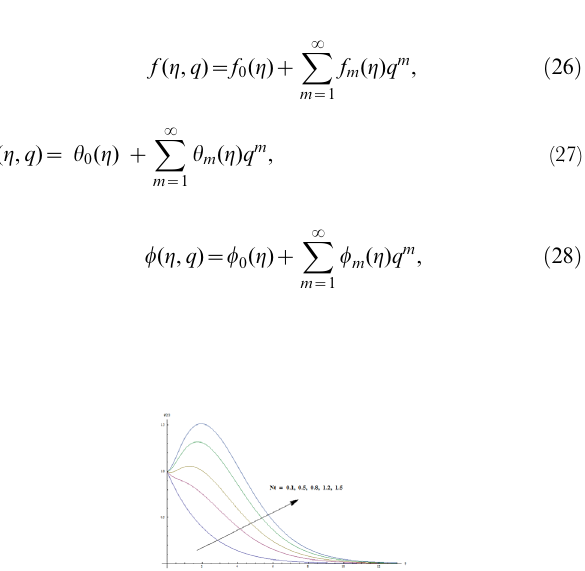
Figure 12. Variation in dimensionless concentration w ( g ) vs g for different values of Nt when l 1 ~ 0 : 3, b ~ 0 : 2, M ~ 0 :